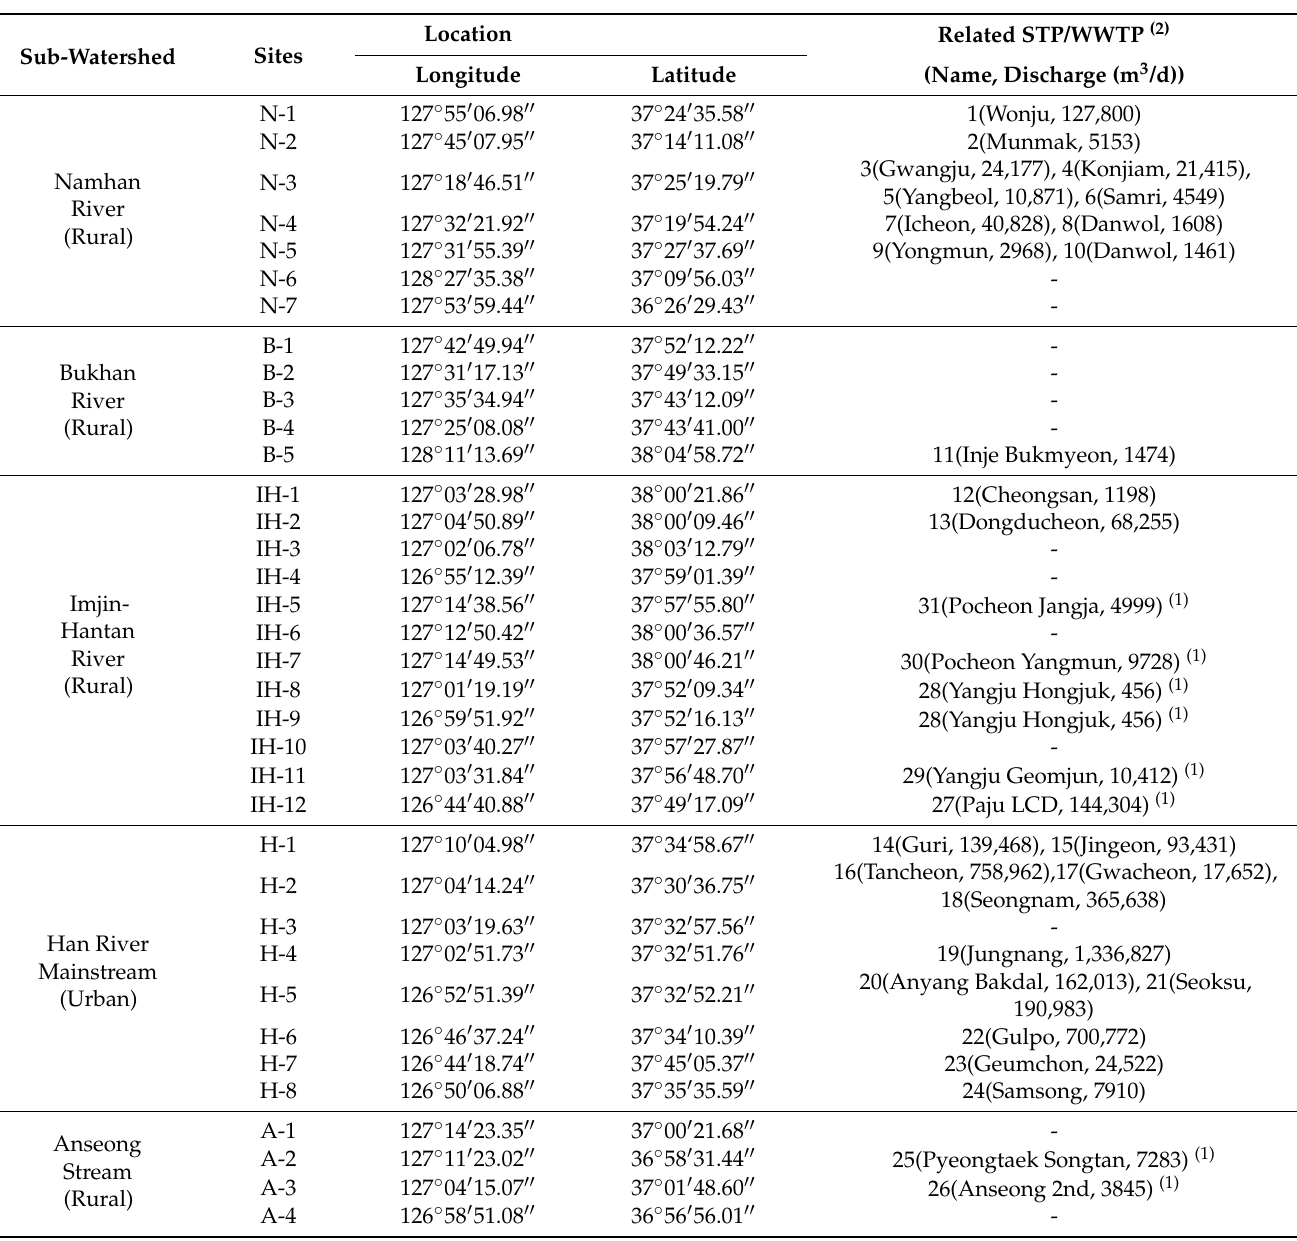
Table 1. Sampling site and point source